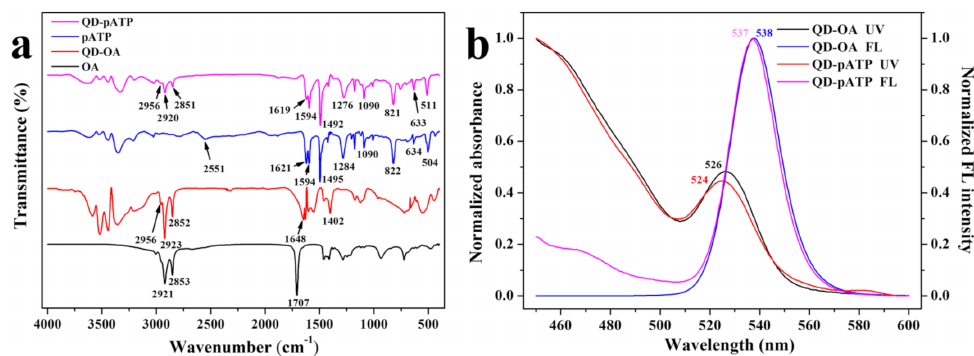
Figure 4. ( a ) FT-IR spectra of OA, CdZnSeS-OA QDs, pATP and CdZnSeS-pATP QDs. ( b ) Normalized UV-Vis spectra and fluorescence spectra of CdZnSeS-OA QDs in n-Hexane and CdZnSeS-pATP QDs in chloroform. ( λ ex = 365